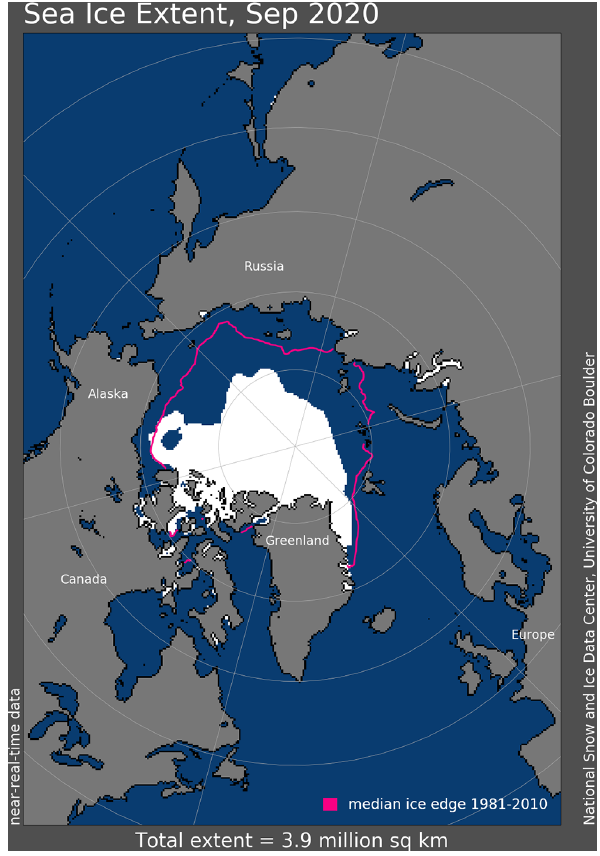
Figure A1. Sea ice extent in September 2020. As illustrated, there is no sign of ice in Bering Strait (Fetterer et al.,